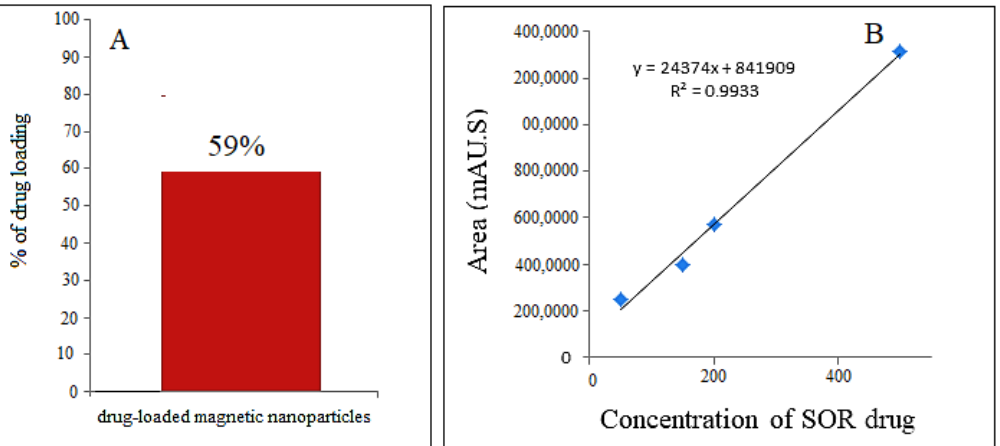
Figure 9. The high-performance liquid chromatography (HPLC) column chart of ( A ) drug-loaded Figure 9. Thehigh-performanceliquidchromatography(HPLC)columnchartof( A )drug-loadedmagnetic magnetic nanoparticles; ( B ) the calibration curve . nanoparticles; ( B ) the calibration curve.